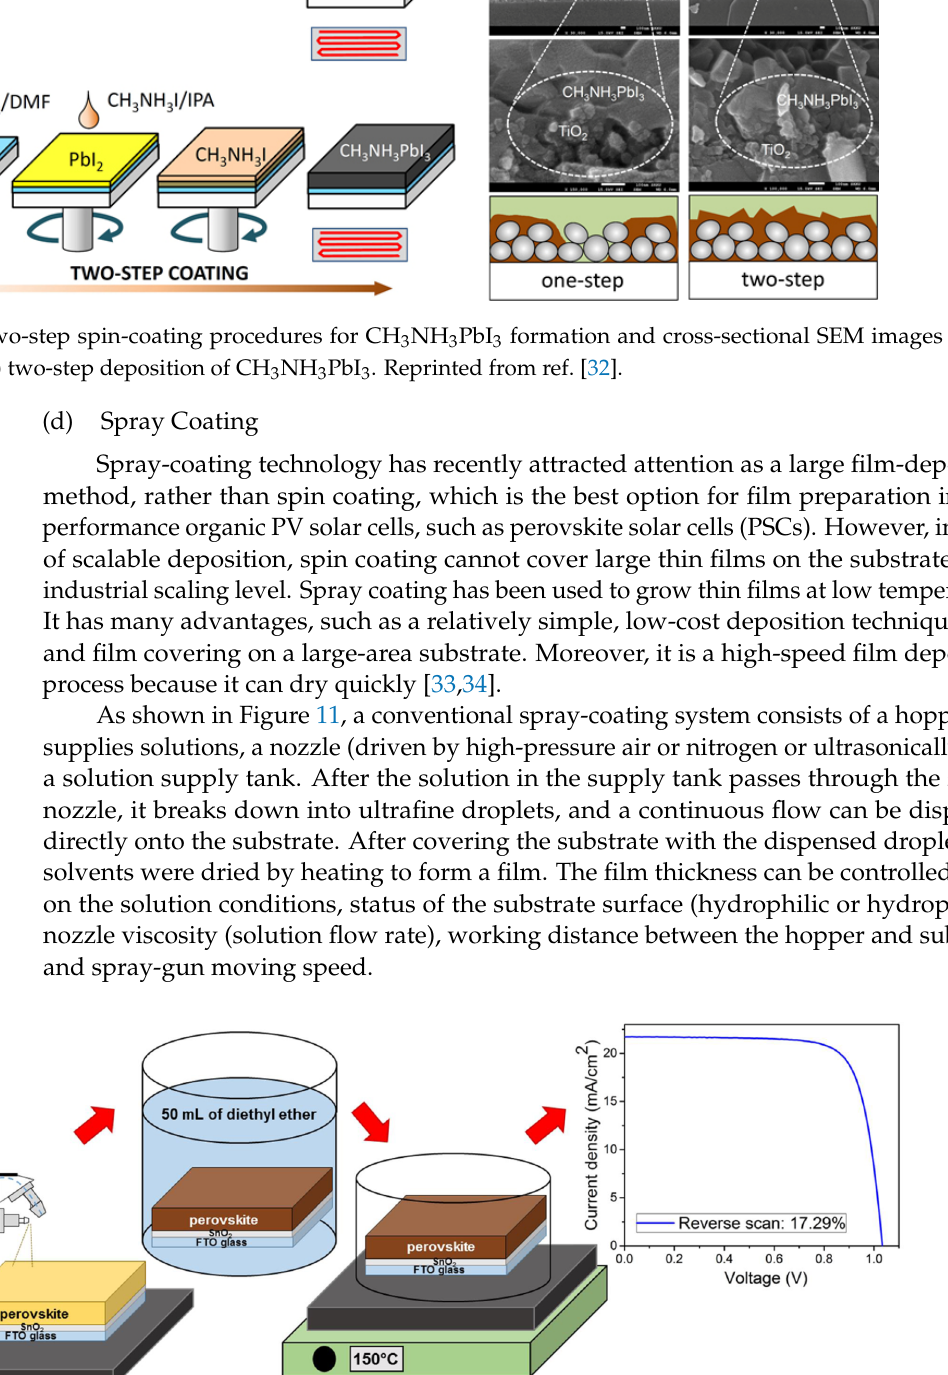
Bishop et al. [36] reported the successful preparation of PSC devices on a 25 mm × 75 mm